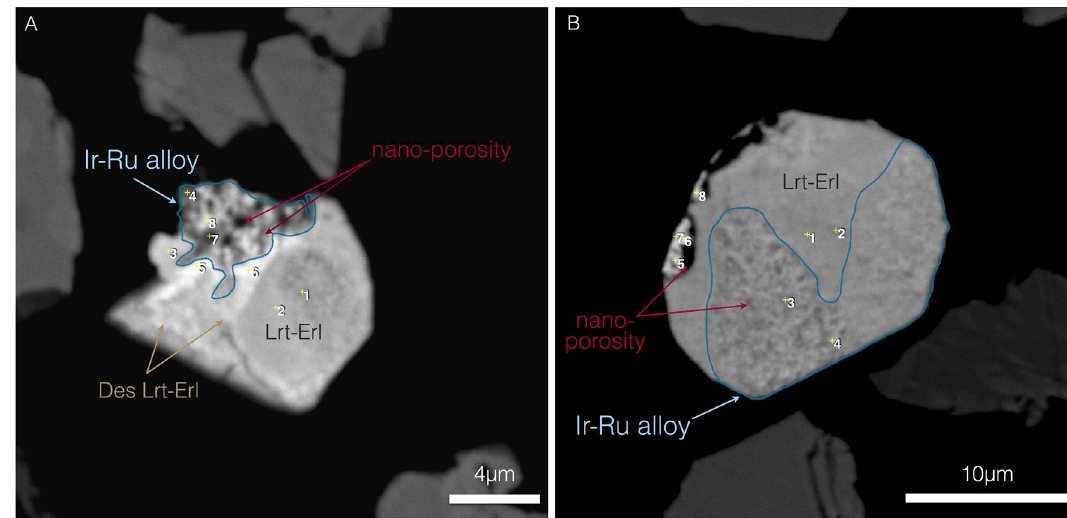
Figure 2. Potential catalytic sites on Ir–Ru alloys with porous structure. ( A ) anhedral, porous structure of the Ir–Ru alloys, limited to one side of the original PGM crystal. The scale bar is 4 μm, ( B ) extensive replacement of the original PGM by Ir–Ru alloys. The scale bar is 10 μm. Abbreviations; PGM: platinum group minerals. Lrt: laurite, Erl: erlichmanite, Des: